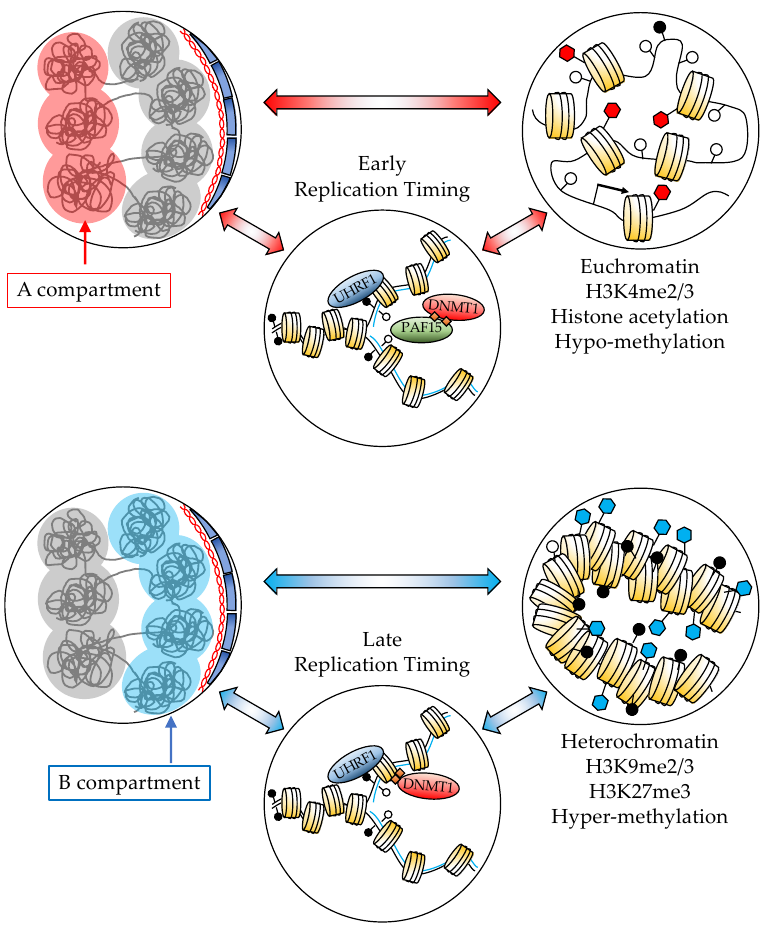
Figure 3. The links between genome compartments, chromatin marks, and epigenome maintenance (histone mark maintenance not depicted, for simplicity).